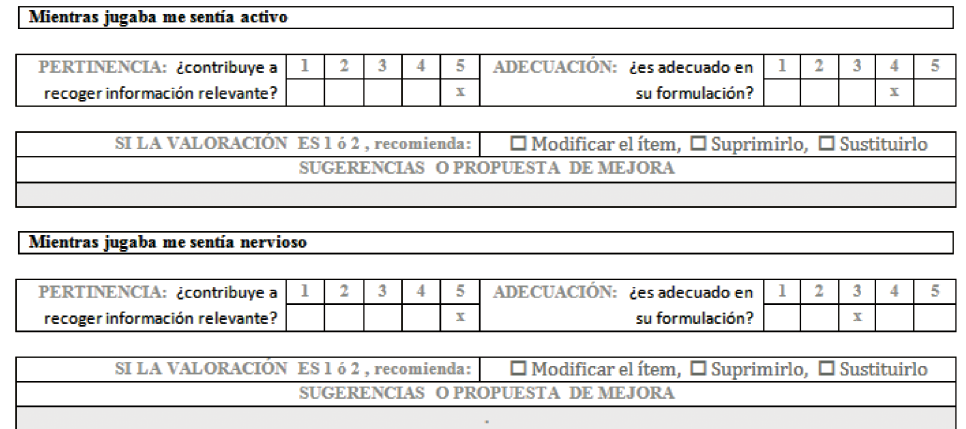
Figure 1. Fragment of the expert assessment scale